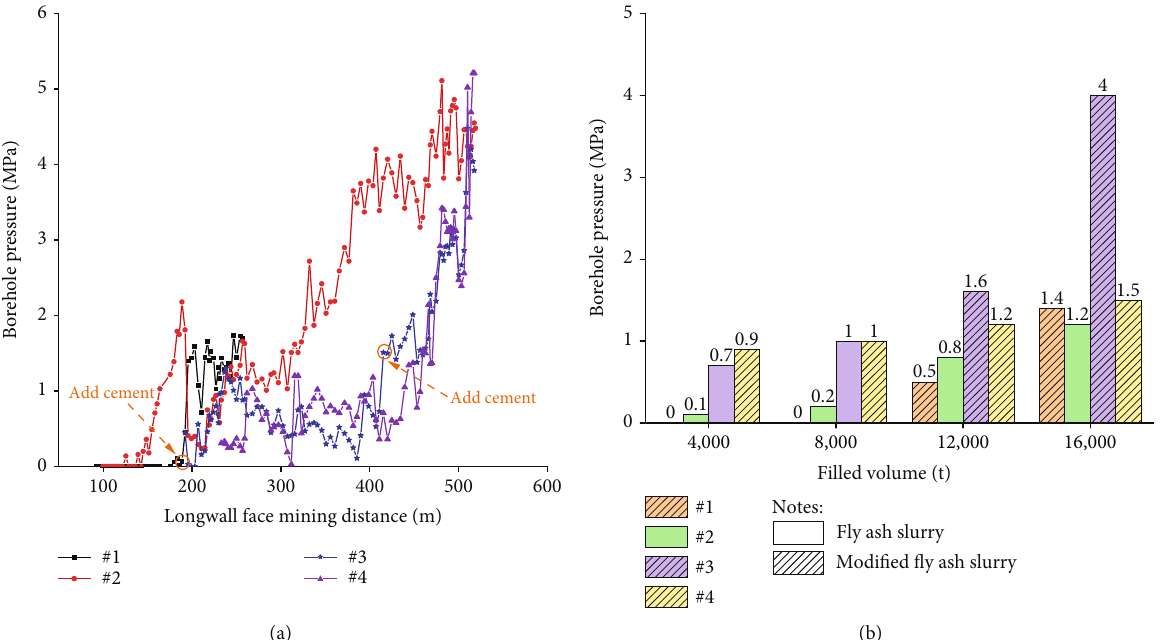
Figure 11: Grouting pressure variation. (a) Boreholes #1 – 4 and (b) borehole pressure at same injection volume of modi fi ed fl y ash slurry and fl y ash